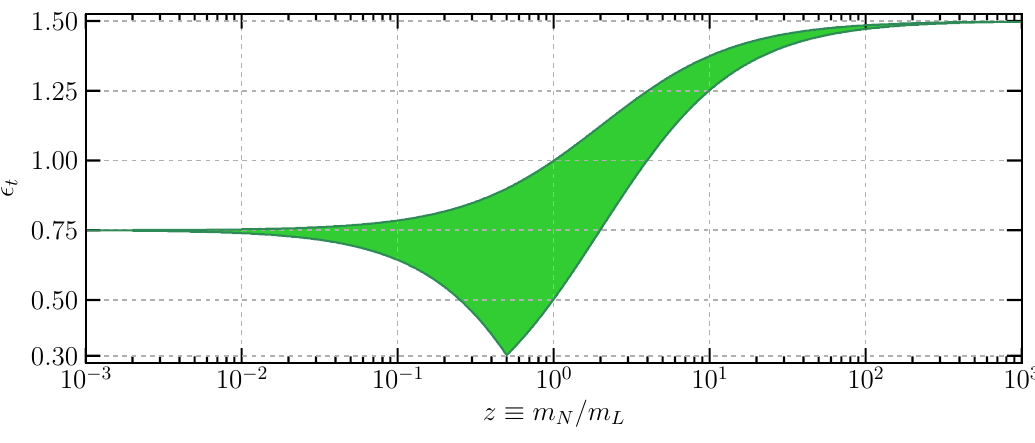
Figure 5 . The green shaded area on this z { (cid:15) t plane is the region of parameter space satisfying eq. (B.28), in which qualitatively similar EWSB dynamics as for the equal-mass case examined in the main body of the paper are